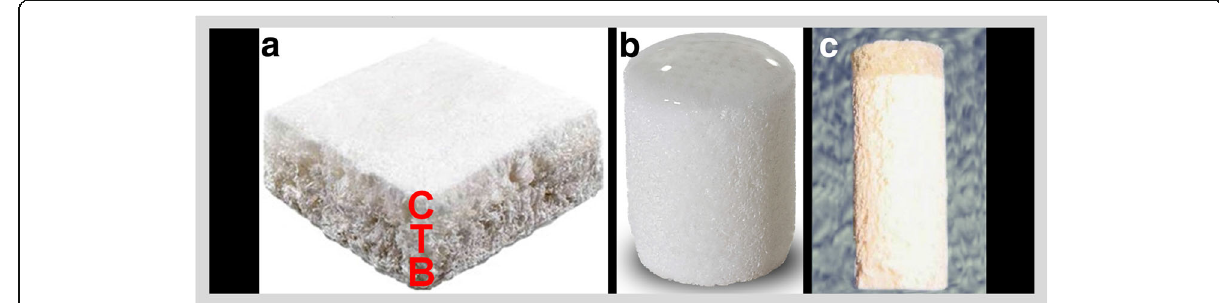
Fig. 3 An osteochondral scaffold (MaioRegen, Fin-Ceramica, Faenza, Italy) has a porous 3D tri-layer composite structure to mimic the osteochondral tissue. The top layer (the red C) is for the cartilage tissue and made from type-I collagen, the transition layer (the red T) is for the transition zone, subchondral bone, and is 60% from type-I collagen and 40% from magnesium-hydroxyapatite, and the bottom layer (the red B) is for the bone tissue and is 30% from type-I collagen and 70% from magnesium-hydroxyapatite ( a ), a bilayer osteochondral scaffold (Agili-C; CartiHeal, Israel) that is currently in clinical trial and made from aragonite and hyaluronic acid shape of cylinders, with a similar surgical technique as the mosaic-like osteochondral transplantation. The top layer is for the cartilage tissue and is from aragonite and hyaluronic acid, and the bottom layer is for bone tissue phase and is from calcium carbonate in the aragonite crystalline form ( b ), a bilayer scaffold (TruFit CB; Smith & Nephew, Andover, Massachusetts) is from poly(lactic-co-glycolic acid), poly(glycolic acid) fibres, and calcium sulphate ( c ). Adapted with a minor modification from (Kon et al. 2014)